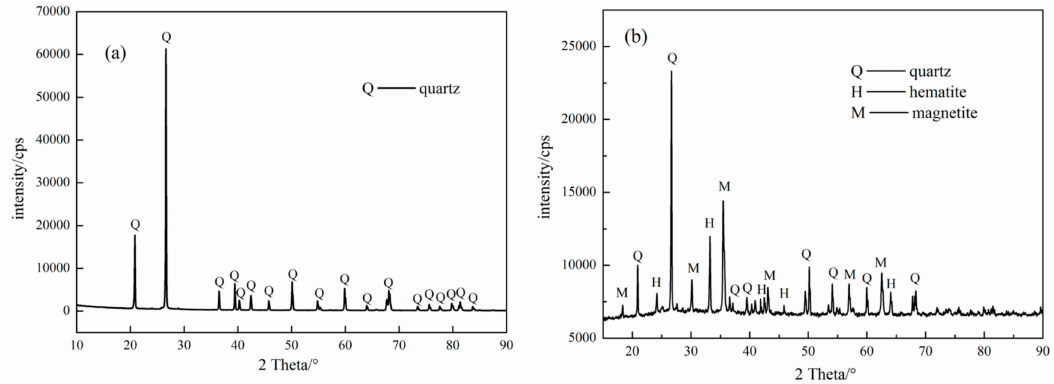
Figure 1. X-ray diffraction patterns of quartz ( a ) and industrial ore ( b